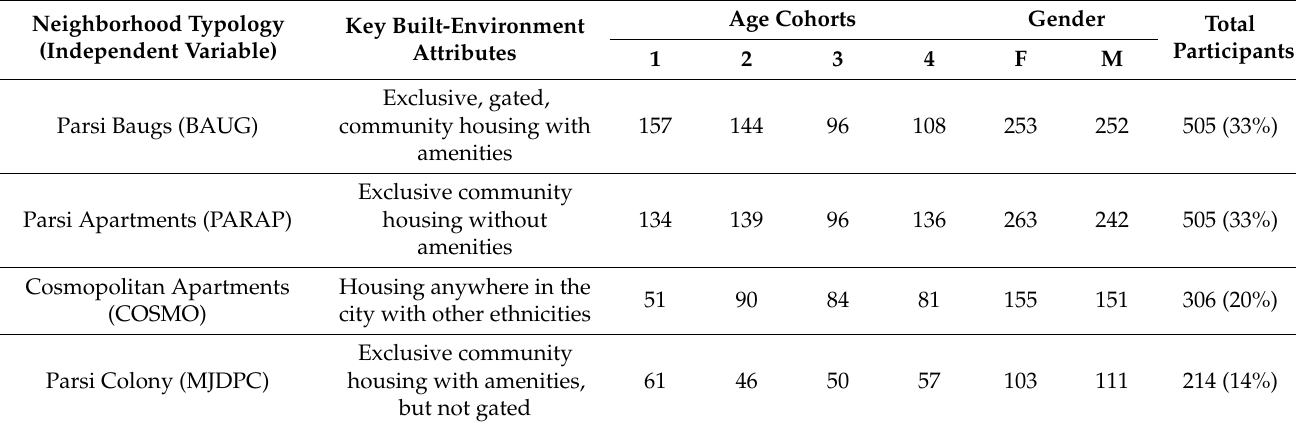
Table 1. Summary of four neighborhoods and